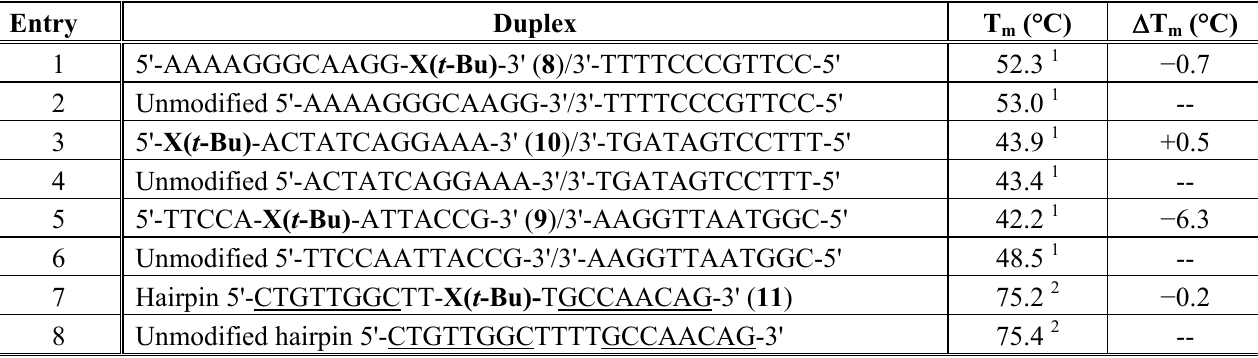
Table 2. Melting temperatures of duplexes carrying the tert -butylsulfanyl threoninol derivative.